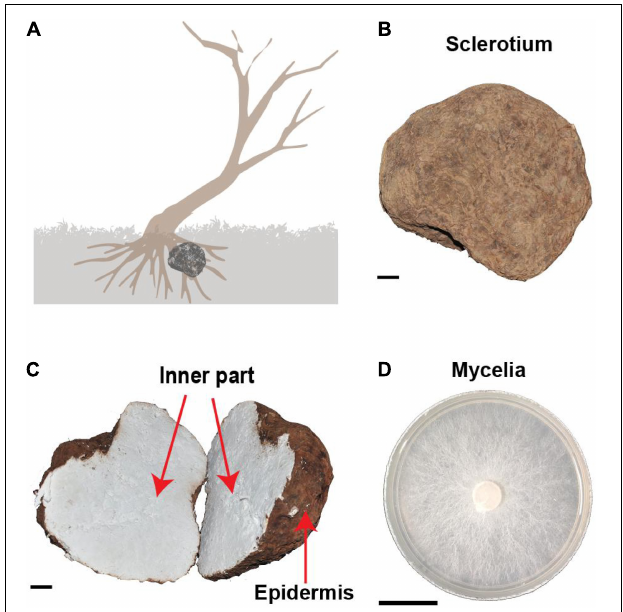
FIGURE 1 | The morphological characteristics of Wolfiporia cocos . (A) The depicted wild W. cocos grows underneath a dead tree in the natural environment. (B) A sclerotium of cultured W. cocos . (C) The cut image of W. cocos sclerotium showing two distinct parts of the epidermis and the inner part. (D) The mycelium of W. cocos grows in a plate. Bar, 2